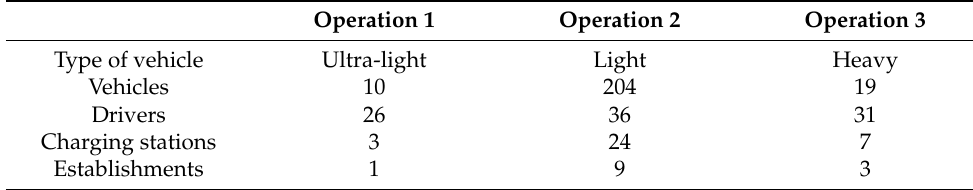
Table 3. Operational